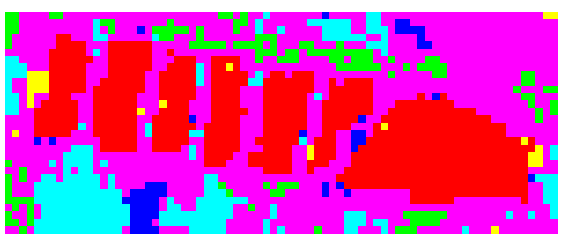
Figure 5: DESIS Maximum Likelihood results. Solar panels class is reported in red. Figure 6: Sentinel-2 Maximum Likelihood results. Solar panels class is reported in red.